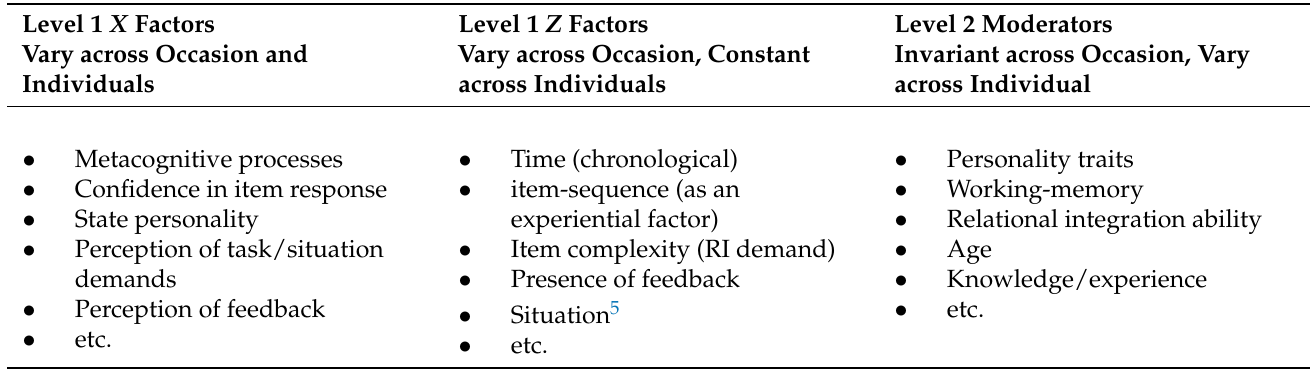
Table 1. Examples contingent (Level 1) and moderating (Level 2) indicators of cognitive